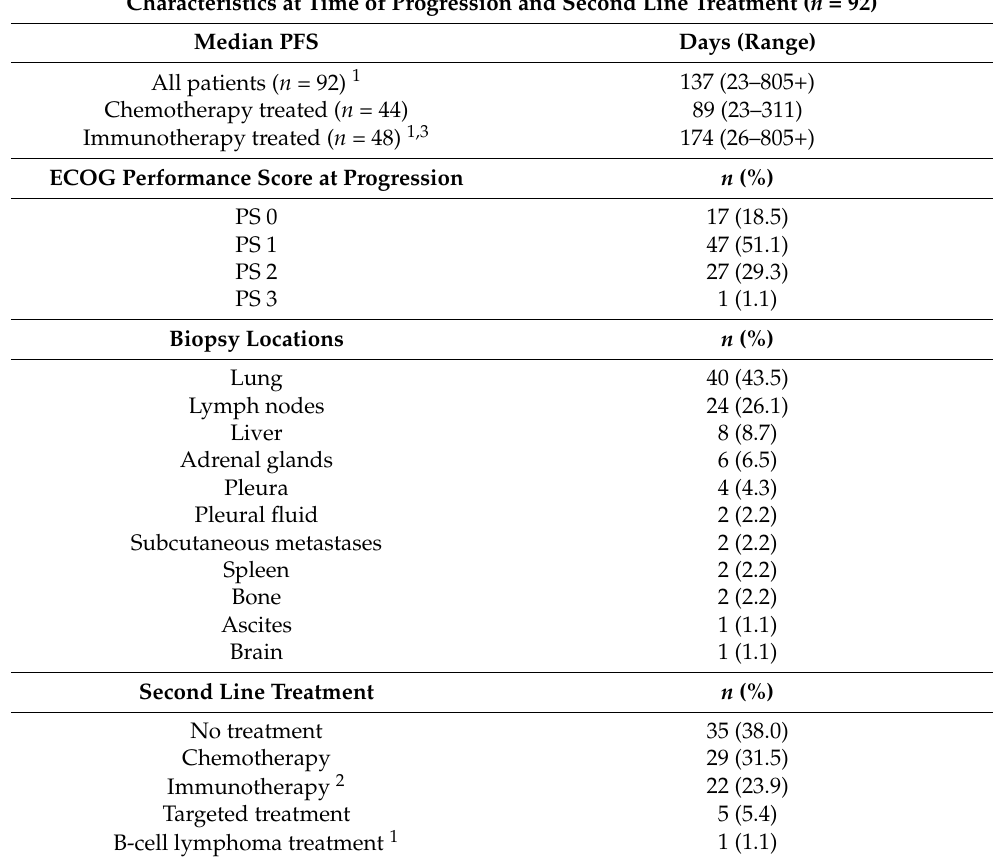
Table 2. Patient and biopsy characteristics at time of progression and second line treatment. Characteristics at Time of Progression and Second Line Treatment ( n =